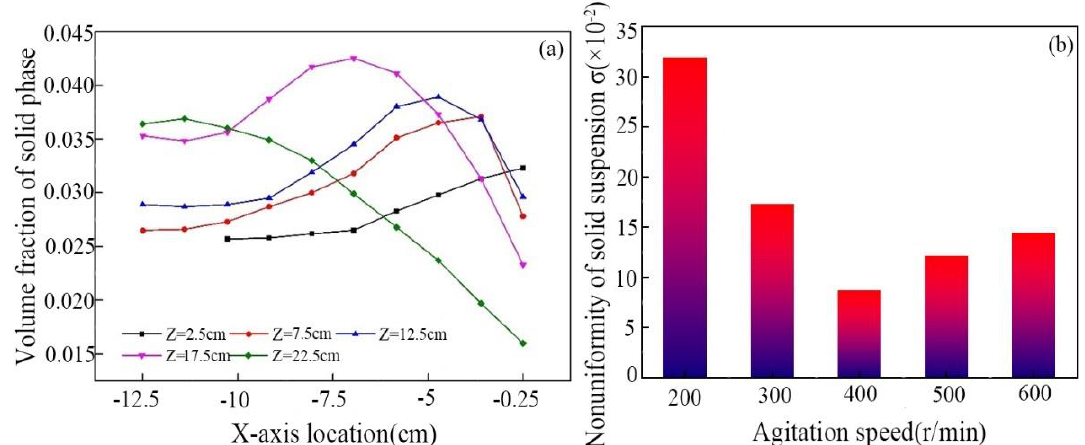
Figure 8. ( a ) Solid volume fraction distribution at different horizontal positions; ( b ) the nonuniformity of solid suspension at different agitation speeds.